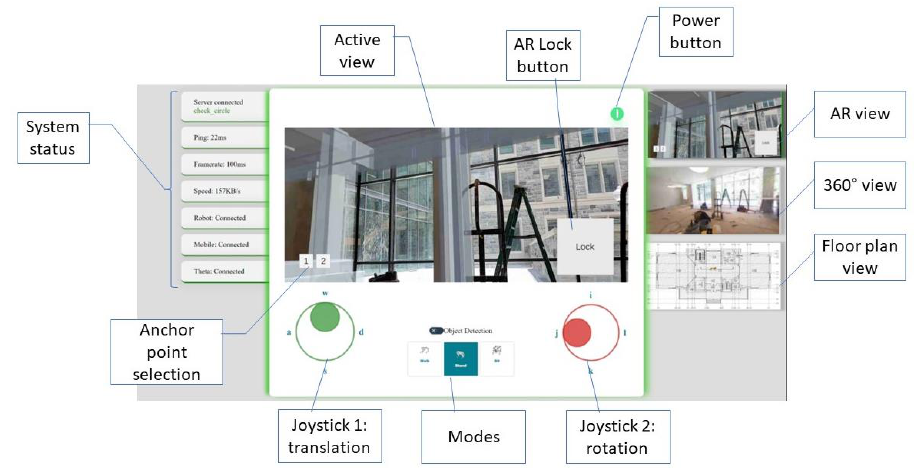
Figure 9. User interface of the developed